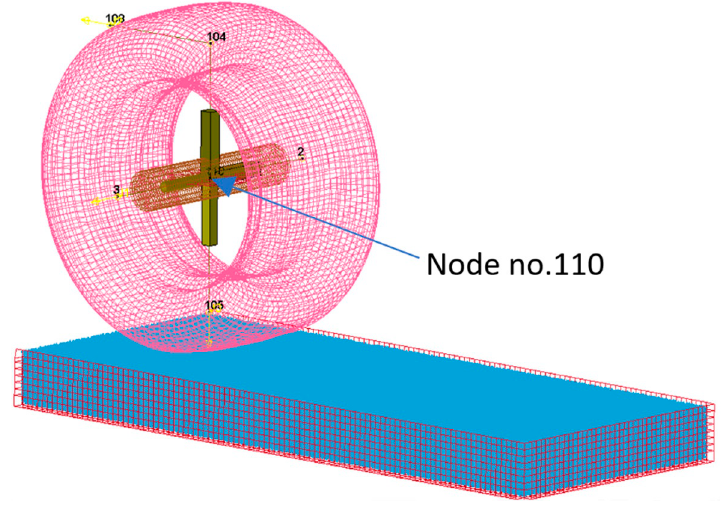
Figure 11. The numerical model with marked joints between the wheel and the shaft.